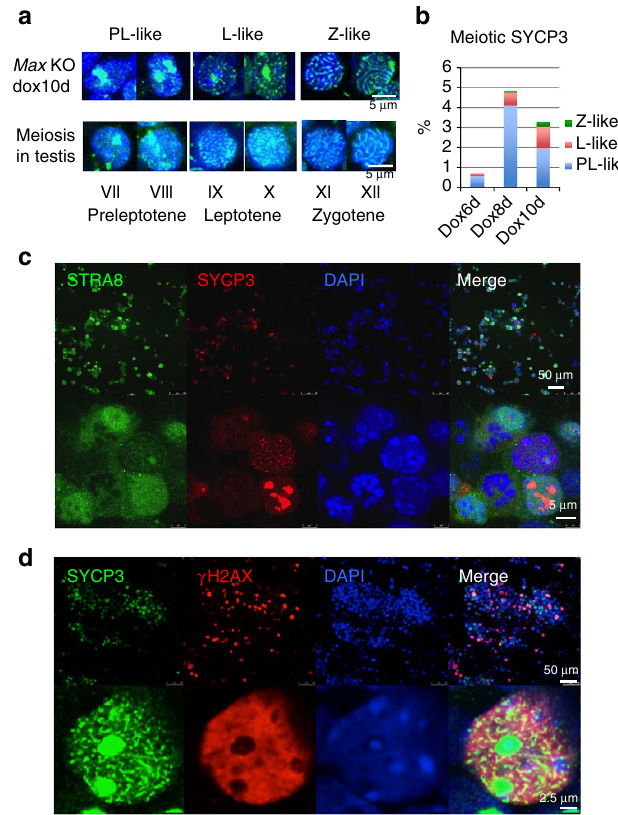
Figure 2 | Cytological changes reminiscent of cells undergoing meiotic cell division processes. ( a ) Meiosis-like SYCP3-staining patterns in Max - null ESCs treated with Dox for 10 days. The meiosis-like SYCP3-staining patterns in Max -null ESCs were classified as preleptotene (PL)-, leptotene (L)- and zygotene (Z)-like patterns according to the criteria shown in Supplementary Fig. 3. ( b ) Frequency of preleptotene-, leptotene- and zygotene-like SYCP3-staining patterns in Max -null ESCs at the indicated days after Dox administration. ( c ) Co-immunostaining analyses of Max -null ESCs treated with Dox for 9 days with antibodies against SYCP3 and STRA8. ( d ) Max -null ESCs treated with Dox for 10 days were co-immunostained for SYCP3 and g